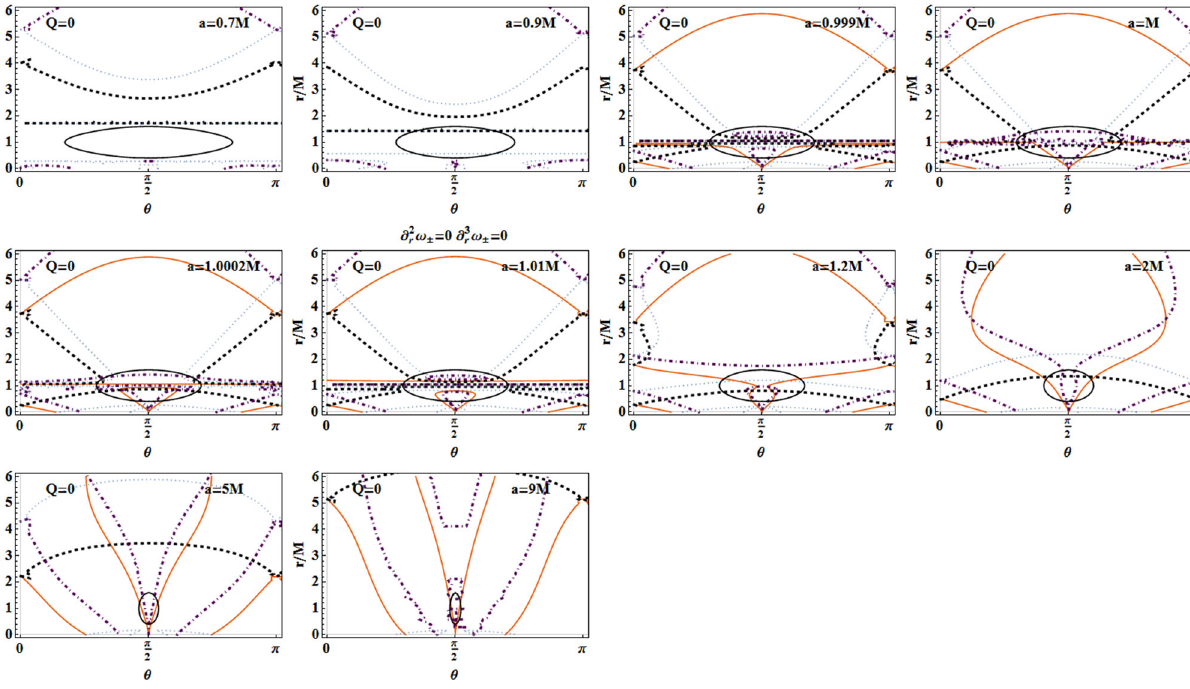
(black), defining the static limits, and g − 1 rr = 0 (red), defining the hori- zons. See also Fig. 29 for the case Q = 0 (Kerr